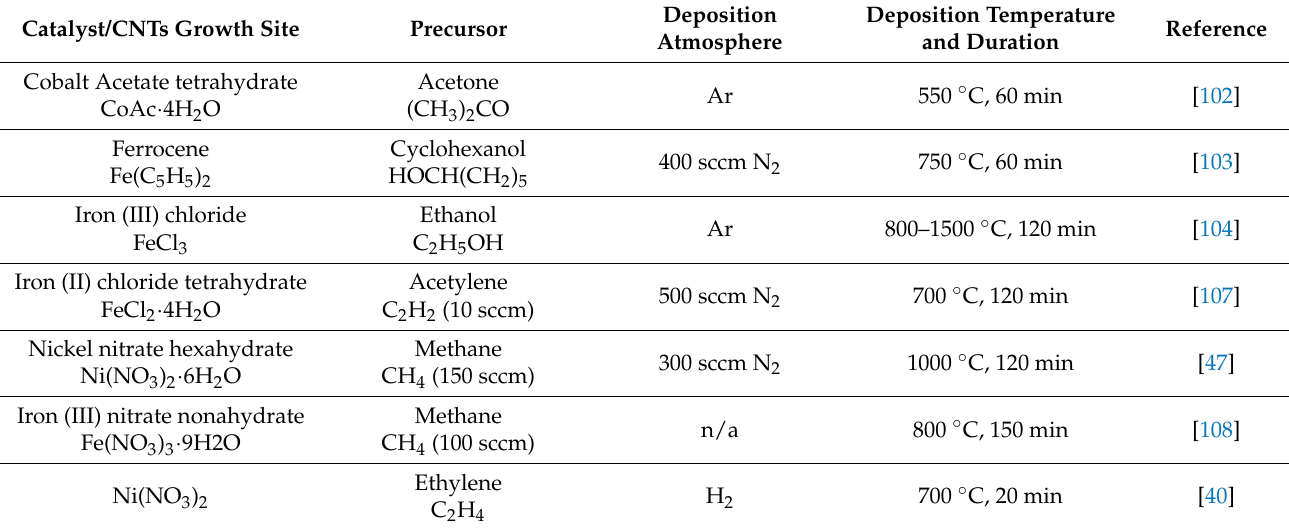
Table 3. The optimum CVD parameters for in situ CNTs growth on